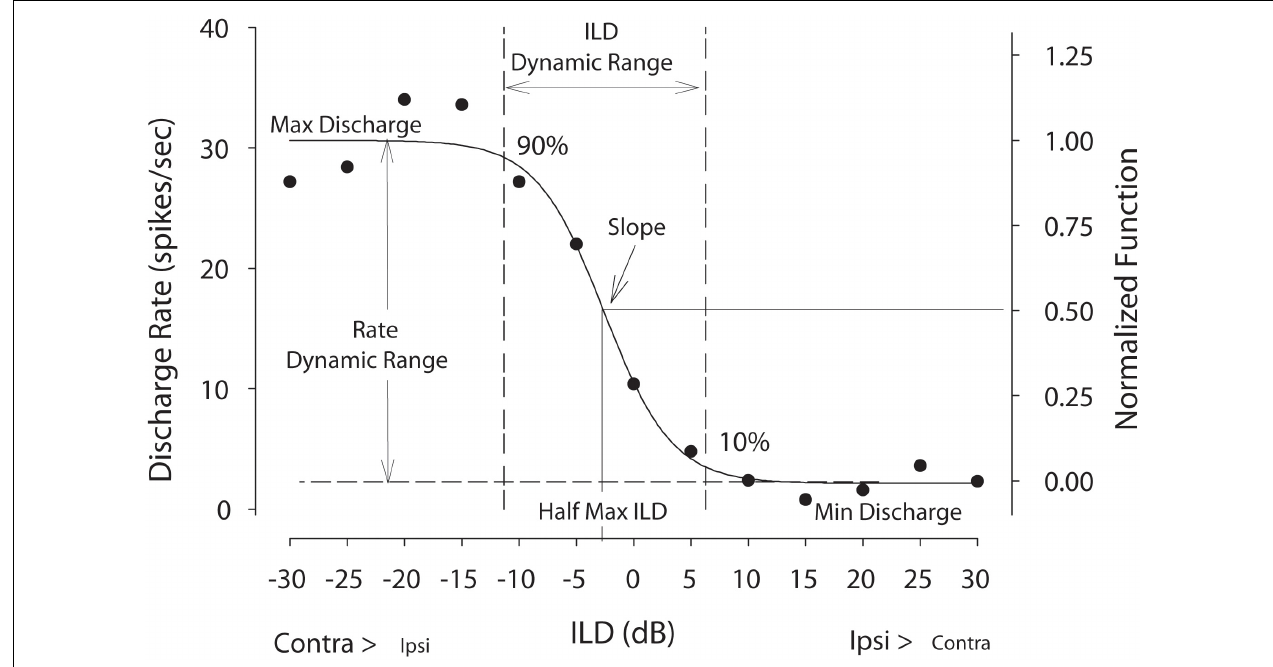
FIGURE 1 | Example discharge rate vs. ILD neural tuning function. Raw spike rate data were fitted with a 4-parameter logistic function from which key tuning parameters were computed including half-maximal ILD—the ILD producing 50% of maximal firing—and ILD dynamic range—the range of ILDs producing 10–90% of maximal firing. Rate dynamic range is defined as the difference between the maximum and minimum rates from the fitted curves divided by the maximum rate. For population level analyses, firing rates were normalized. This figure was adapted from Jones et al.